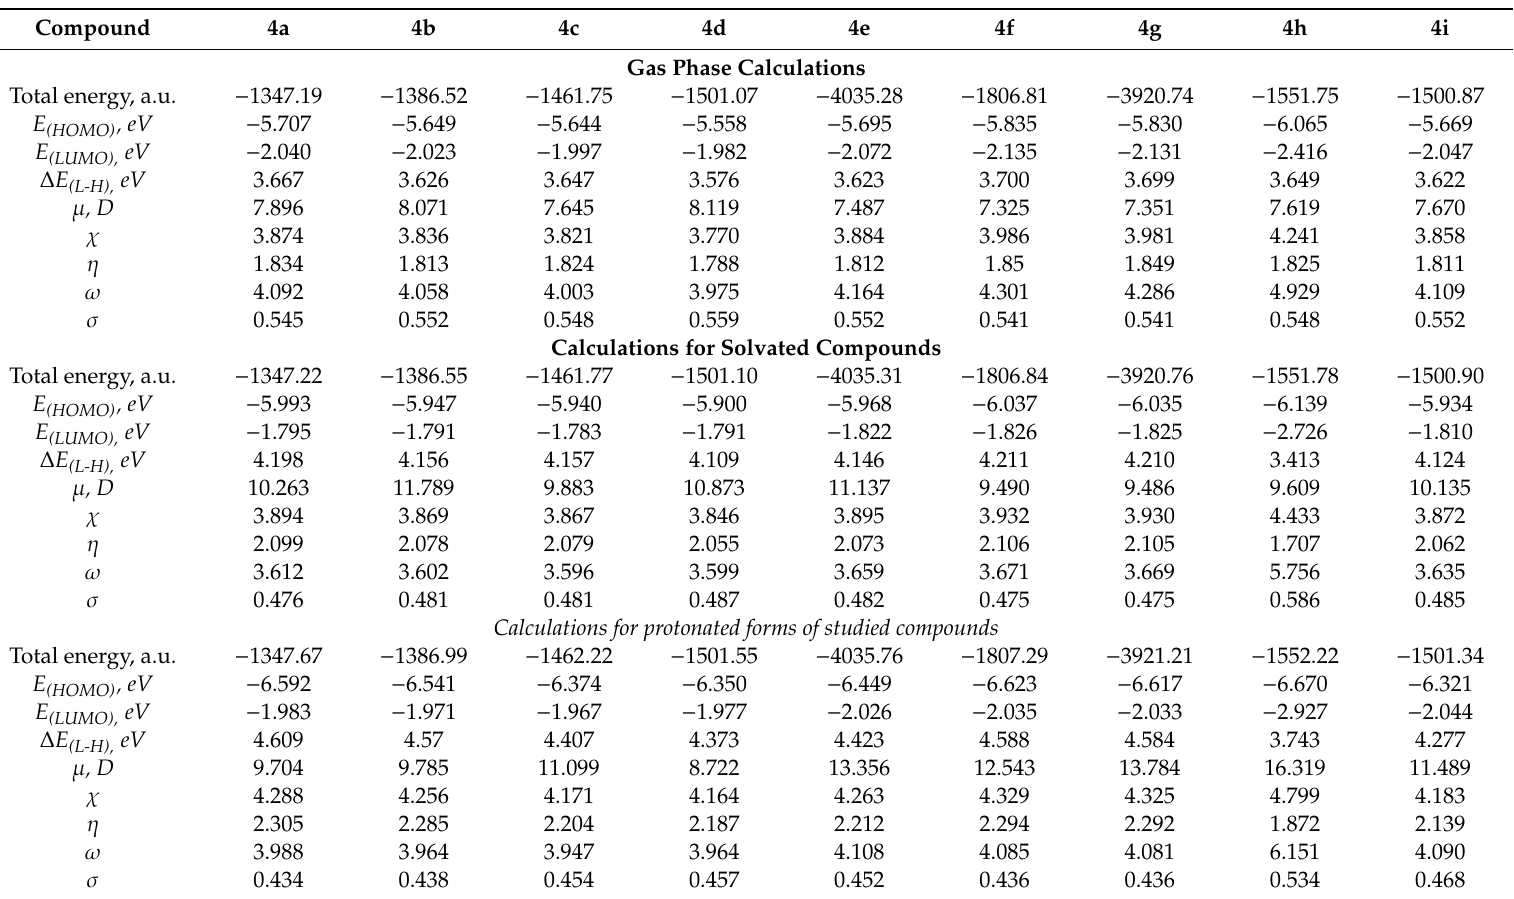
Table 3. Results of quantum chemical calculations for studied compounds 4a – i